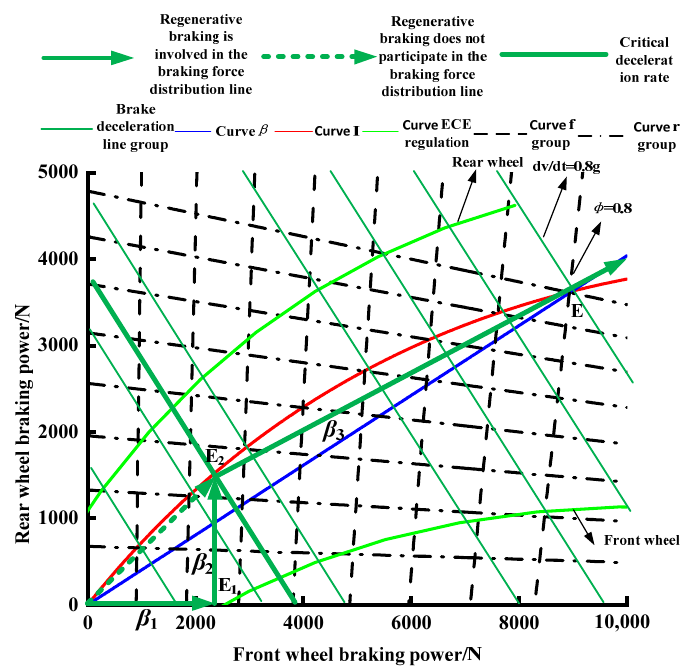
Figure 5. The braking force distribution basis diagram.